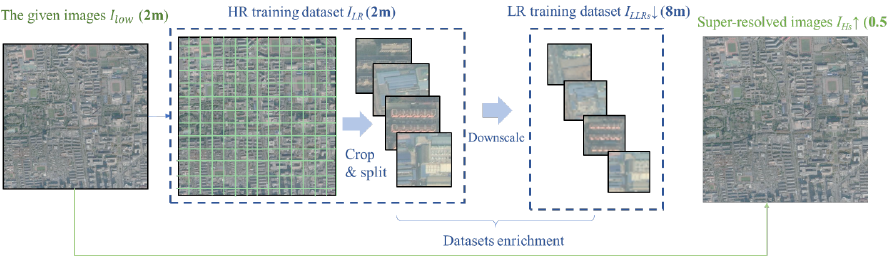
Figure 2. An example workflow of the proposed LR-HR training pairs generation with a scaling factor of 4. In this example, I low represents the raw remote sensing images (2 m), which usually consists one or two images with a large size and covering a large area. I LR represents HR patches (2 m), which is generated via cropping and splitting the I low . For each image patch in I LR , we generate its downscaled version, which consists the corresponding LR training pairs I LLRs ↓ (8 m). Several dataset enrichment schemes were applied to the LR-HR training pairs. After the super-resolution model was properly trained on the LR-HR training pairs, the trained SR model takes the given images I low (2 m) as input to generate super-resolved images I Hs ↑ (0.5